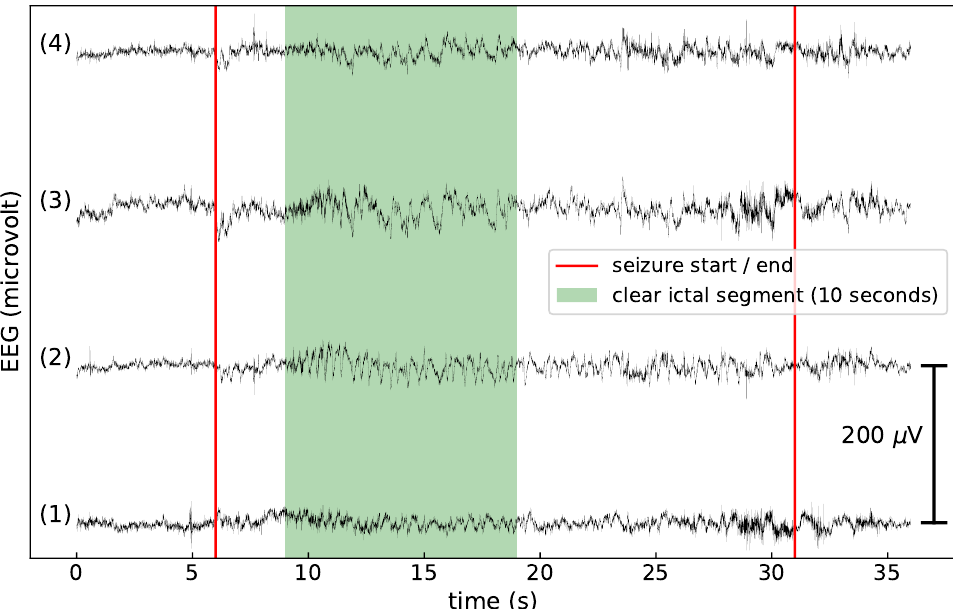
Figure 2. An example of the full seizure and clear ictal labels, used to train the full seizure SVM and clear ictal SVM. ( 1 ) Crosshead 1, ( 2 ) crosshead 2, ( 3 ) unilateral left, ( 4 ) unilateral right. The full seizure, as annotated by the neurologists, occurs between the vertical red lines. A 10-s EEG segment that contains a clear ictal pattern is also